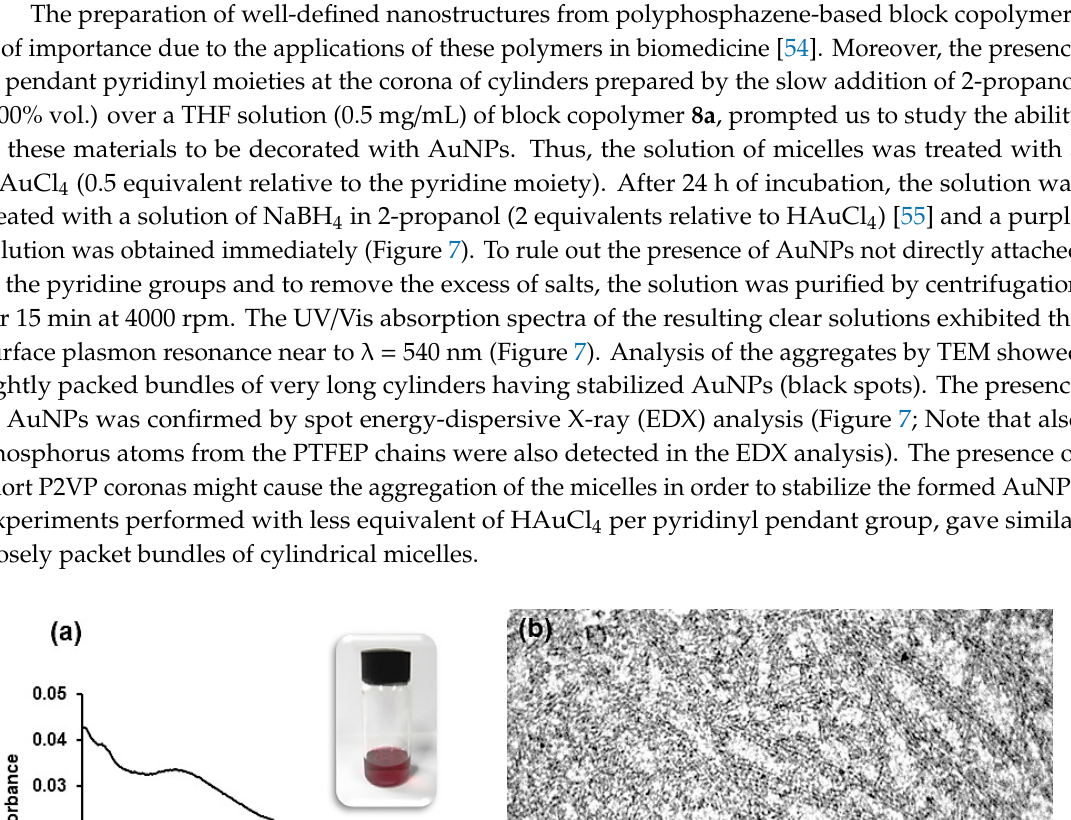
Figure 6. WAXS (wide-angle X-Ray scattering) diffractograms for bulk samples of BCP 8a , cylindrical micelles from 8a at 50 and 100% vol. of 2-propanol added, and spherical micelles resulted from the quick addition (one-step) of 100% vol. of 2-propanol.